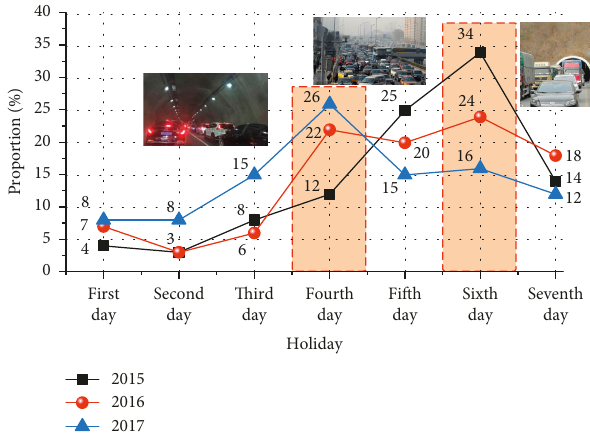
Figure 13: Traffic accident distributions during Chinese Spring